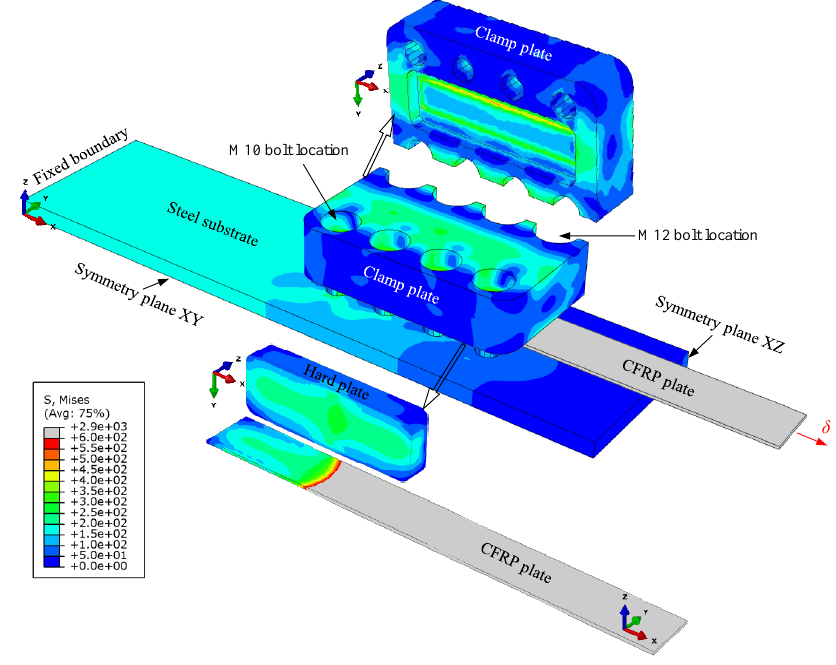
Figure 2. Finite element model created in Abaqus and distribution of von Mises’ stresses in different components of the proposed mechanical clamping system at ultimate anchorage capacity.